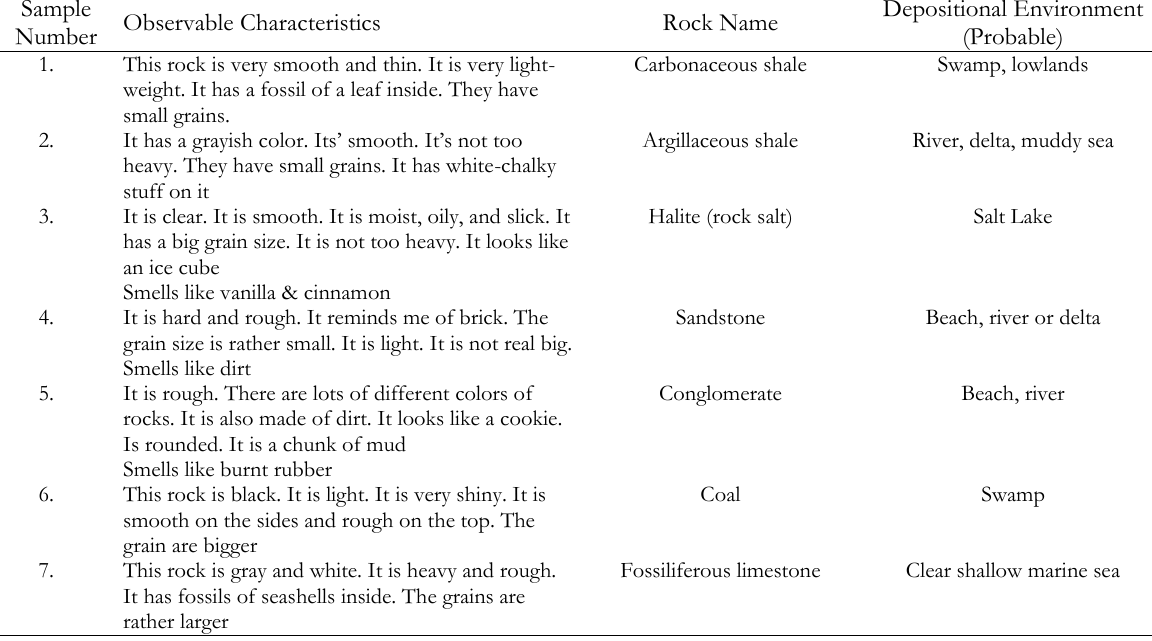
Table 2. Handout students used to complete task. modified worksheet from Ward (1999) Natural Science